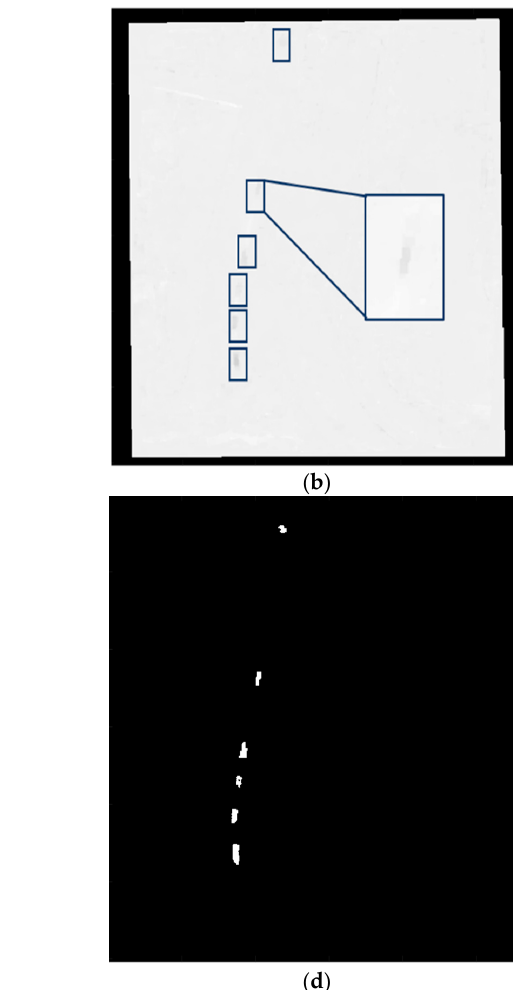
Figure 7. Frame 49 detection results: ( a ) video SAR image; ( b ) foreground image; ( c ) motion track; ( d ) final detection result.